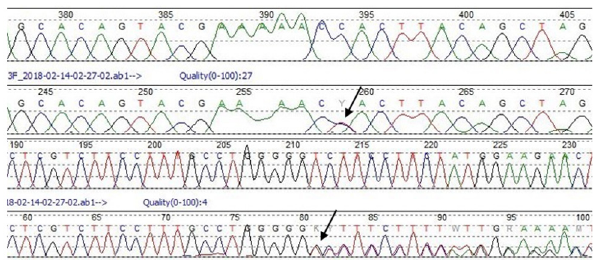
Figure 5. Sanger sequencing chromatograms showing heterozygous c.2416dupG variant in the exon 17 of the LDLR gene (upper chromatogram) and heterozygous c.10708C>T variant in the exon 26 of the APOB gene (lower chromatogram). The top lane picks refer to wild type sequence. The middle lane picks present described aberrations.